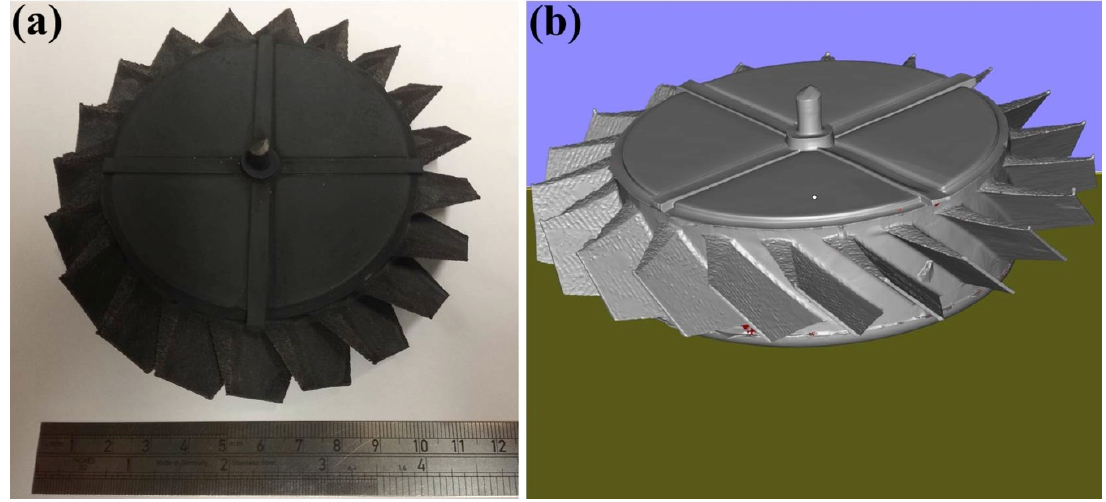
Figure 14. ( a ) Image of Fe-tooling SLM/HIP of CM247LC blisk with IN718 inserted solid disk; ( b ) 3D image of Fe-tooling SLM/HIP of CM247LC blisk with IN718 inserted solid disk scanned using GOM scanning.